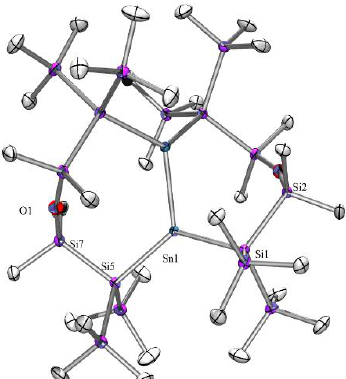
Figure 4. Molecular structure of compound 8 (thermal ellipsoid plot drawn at the 30% probability level). All hydrogen atoms are omitted for clarity (bond lengths in Å, angles in deg). Sn(1)-Si(1) 2.6131(8), Sn(1)-Si(5) 2.6179(8), Sn(1)-Sn(1A) 2.7409(9), Si(1)-Si(2) 2.3557(10), Si(7)-O(1) 1.6302(8), Si(7)-